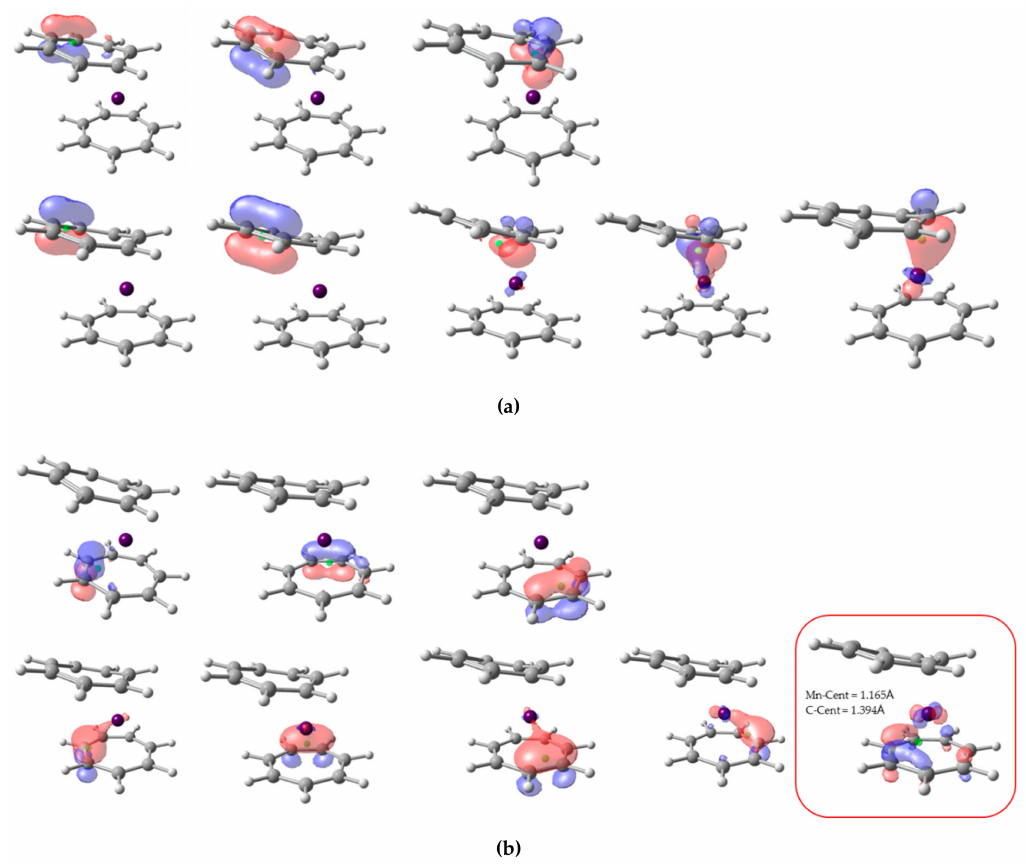
Figure 7. Isocontour plot (0.1) of NLMO localized on top ( a ) and bottom ( b ) π -ligands for Mn(C 7 H 7 ) 2 . In each case, top three orbitals correspond to alpha spin, and bottom five to beta spin. Orbital centroid represented by green